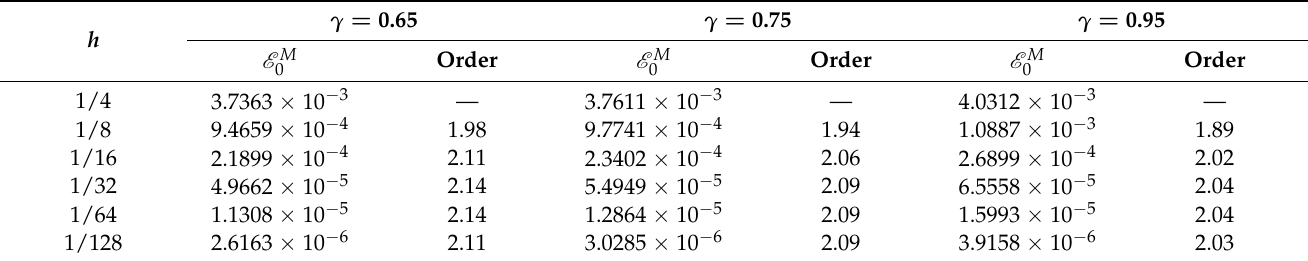
Table 2. E M and numerical convergence order in the spatial direction ( k = 1.25 × 10 − 6 ). 0